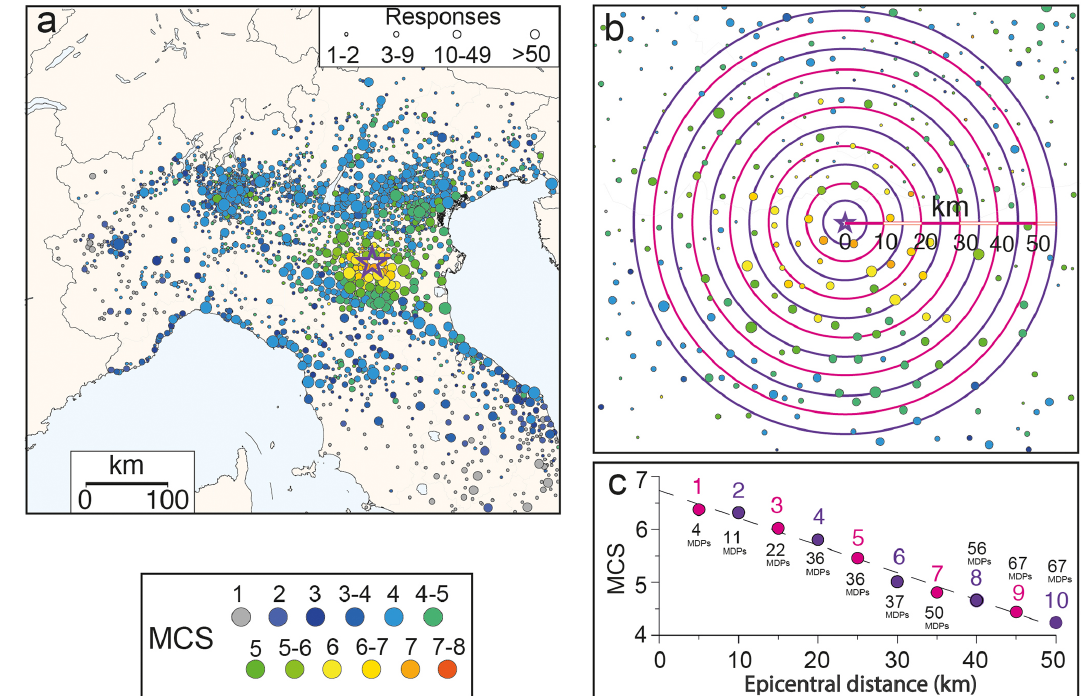
Figure 2. Workflow of the moving-window procedure. (a) Macroseismic field of the 20 May 2012 earthquake (ID 13 in Table 1) from the HSIT database (available at https://e.hsit.it/772691/index.html, last access: 22 December 2022). The highest intensities are shown in the foreground. (b) Map showing the first 50km from the instrumental epicenter and the 10 ring-shaped search areas centered in the instrumental epicenter (shown by magenta and purple lines), each one shifted by 5km with respect to the previous one. (c) Plot of the 10 intensity values obtained averaging the MDPs falling in each of the rings, with no. 1 reporting the average intensity calculated for the 0–10km search area, no. 2 reporting the average intensity for the 5–15km search area, and so